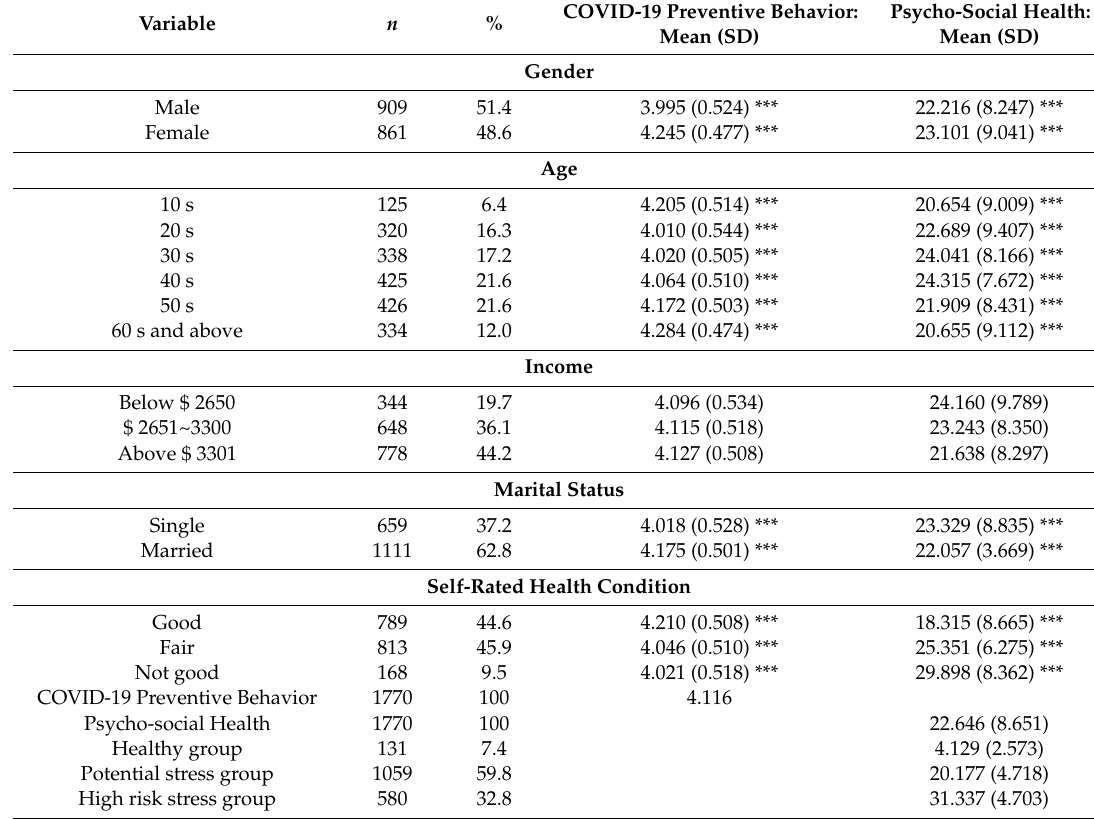
Table 1. Characteristics of the participants ( n =